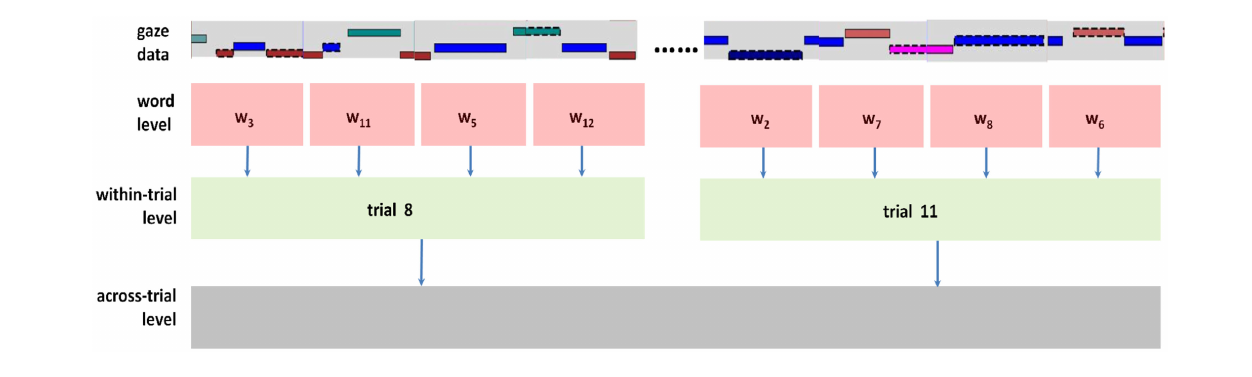
FIGURE 2 |Three levels of eye movement analysis: (1) word level: where participants attended when hearing a word; (2) within-trial level: how they coordinated their attention on objects when hearing